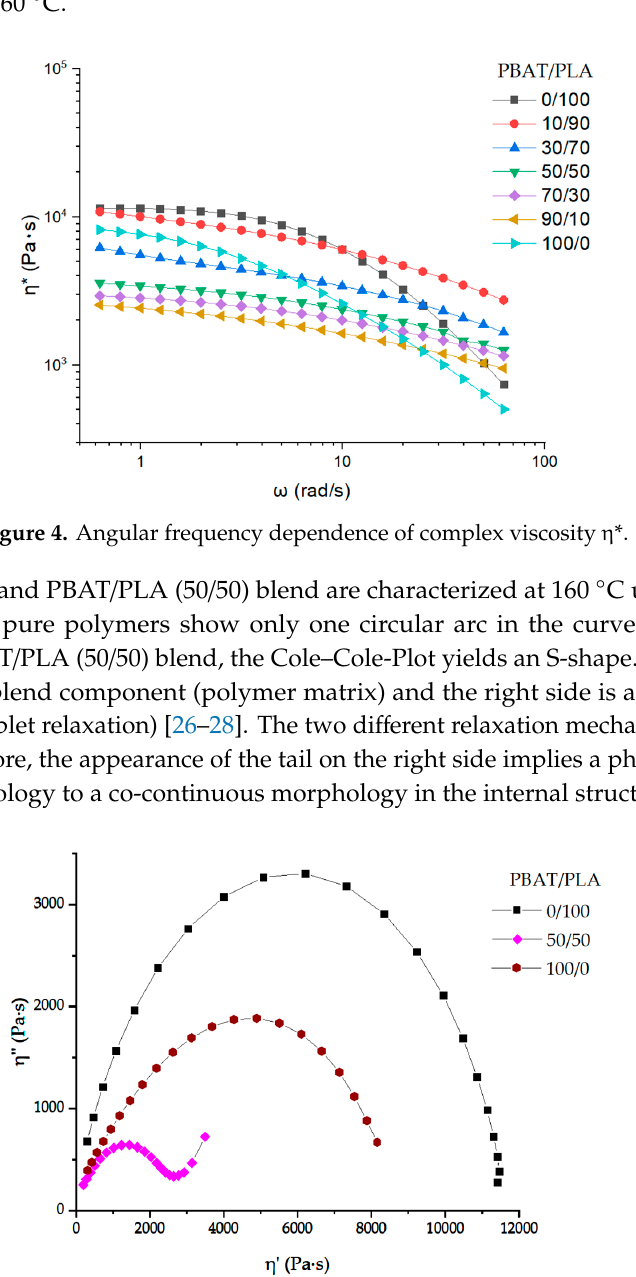
Figure 5. Cole–Cole plot (imaginary viscosity versus real viscosity) for PBAT/PLA (50/50) blend, pure PBAT and PLA at 160 °C.